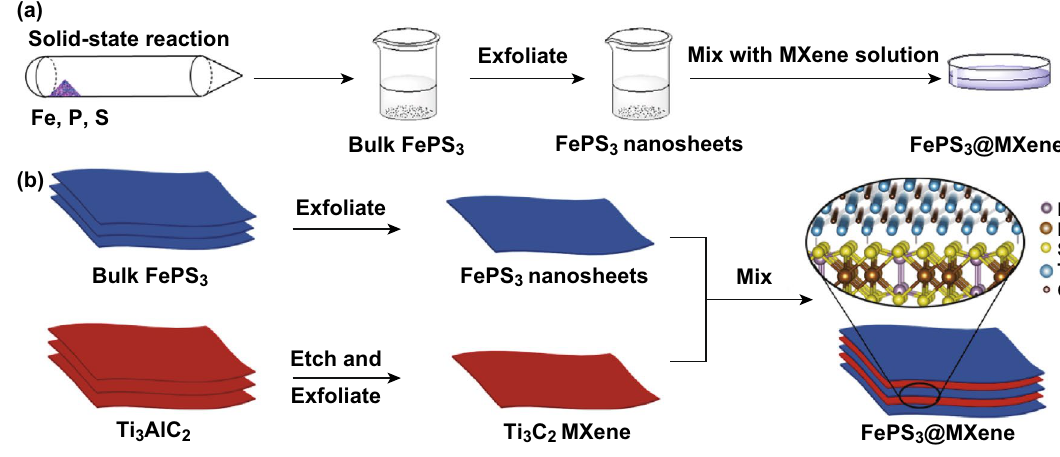
Fig. 1 a Synthesis process diagram of FePS 3 @MXene. b Schematic illustration of MXene assembled on FePS 3 nanosheets surface and the micromolecular structure in enlarged